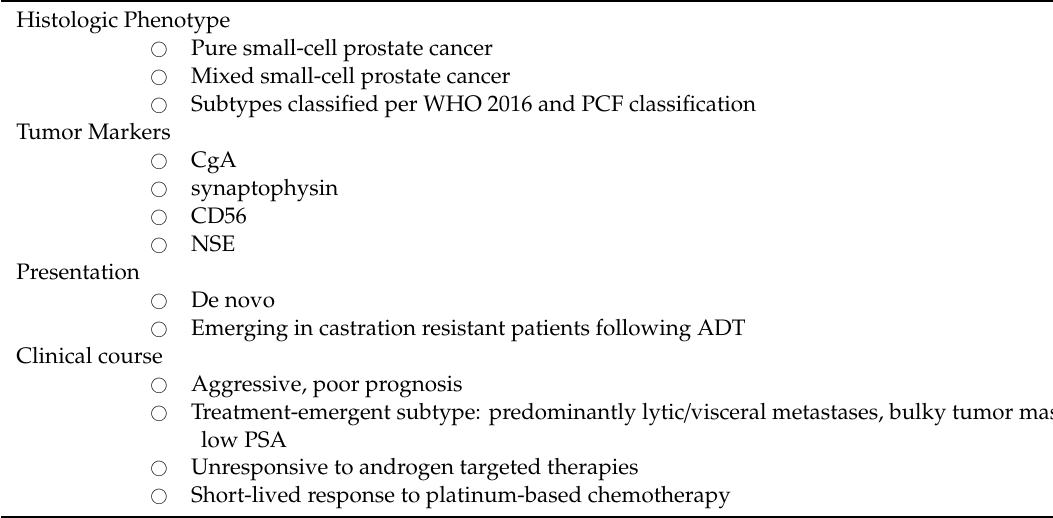
Table 2. Characteristics of prostate cancer with NE di ff